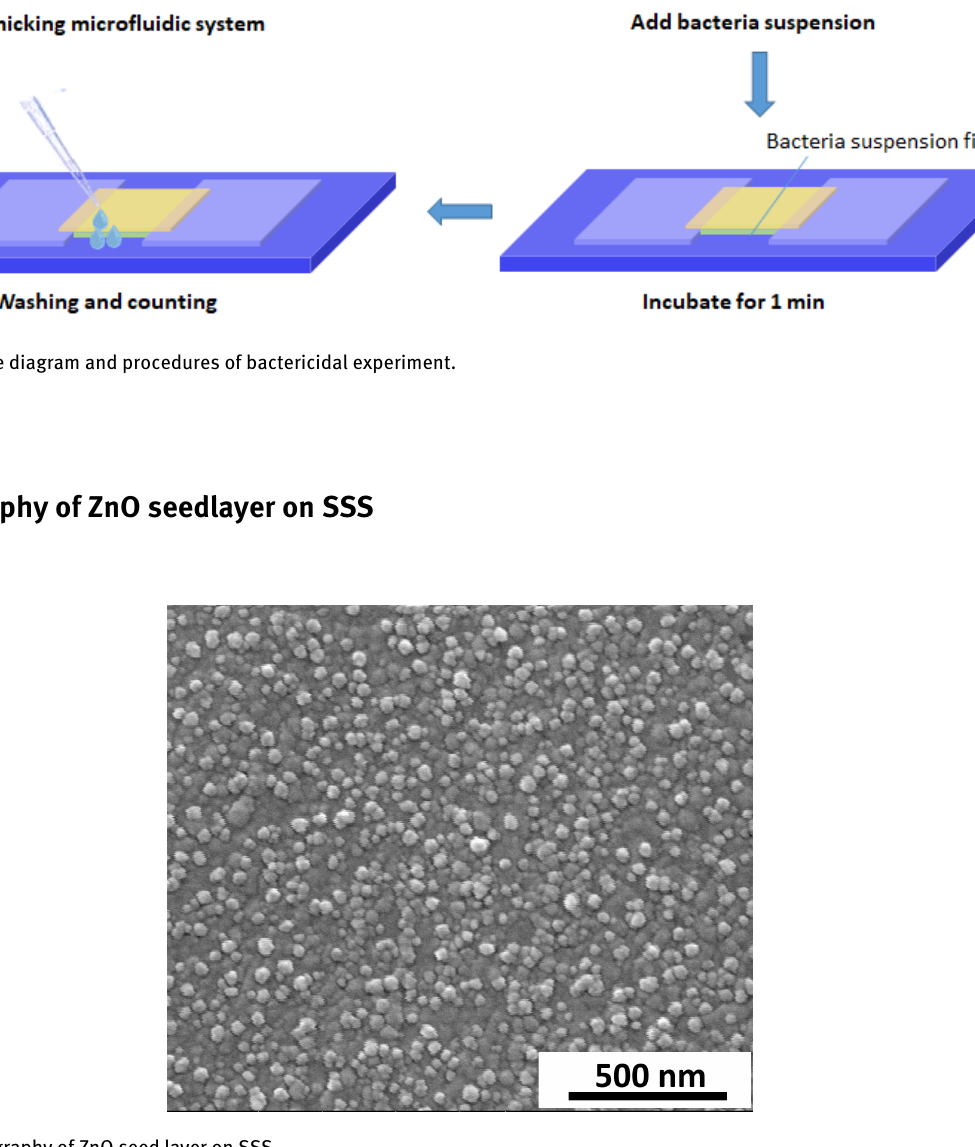
Figure S2: Topography of ZnO seed layer on